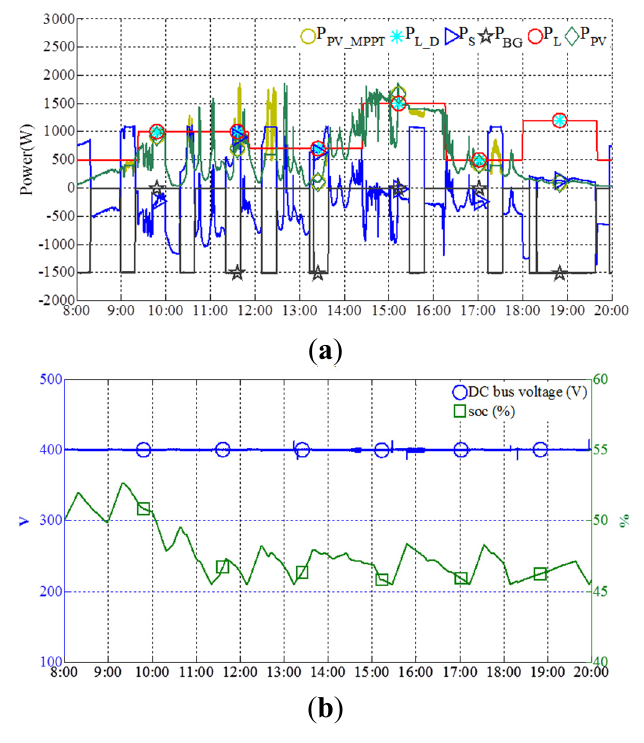
Figure 15. ( a ) Experimental real-time power flow for Test 3; ( b ) Experimental DC bus voltage and soc evolution for Test